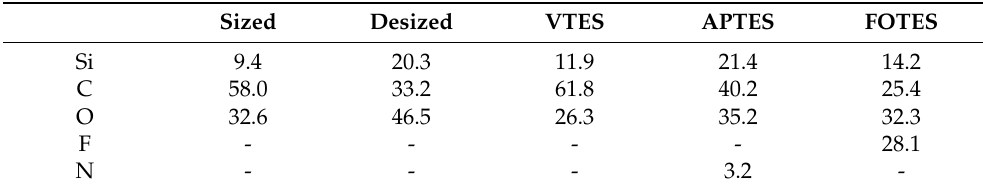
Table 2. Chemical surface composition of glass fibers prior to and after desizing and attachment of functional organo-silanes in atom-%.